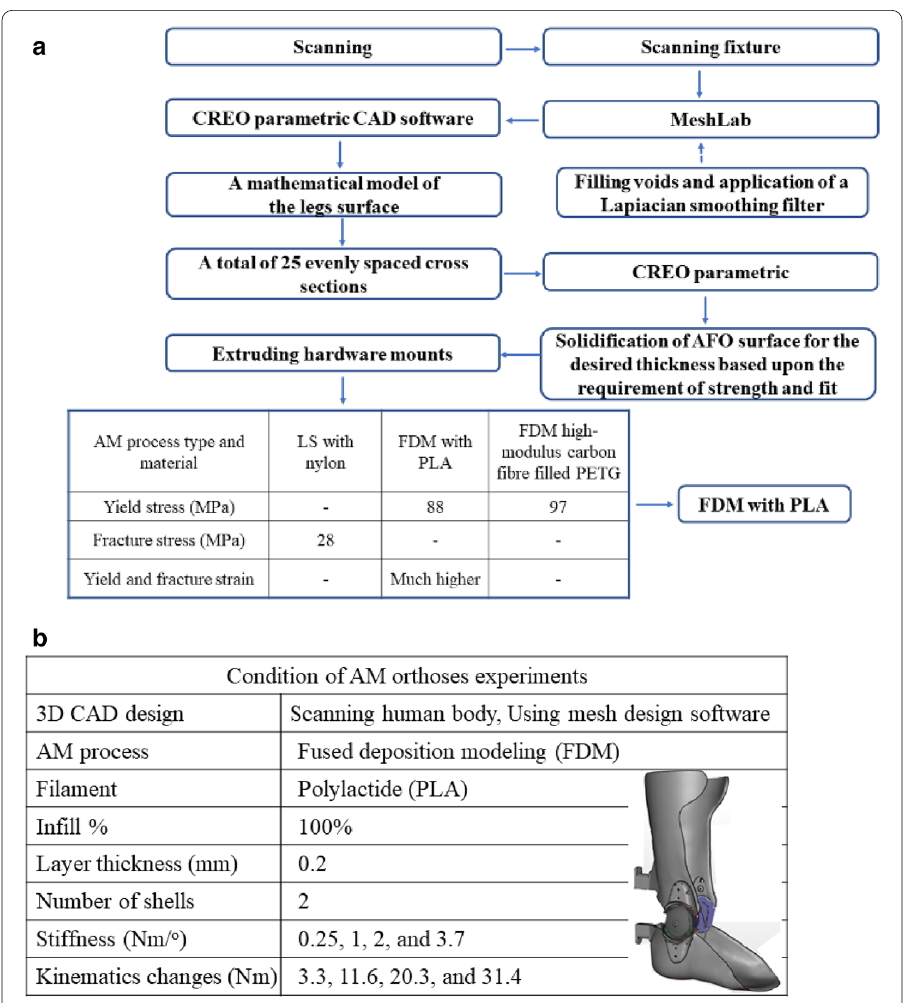
Fig. 4 Examples of AM AFO fabrication condition. *PETG means polyethylene terephthalate